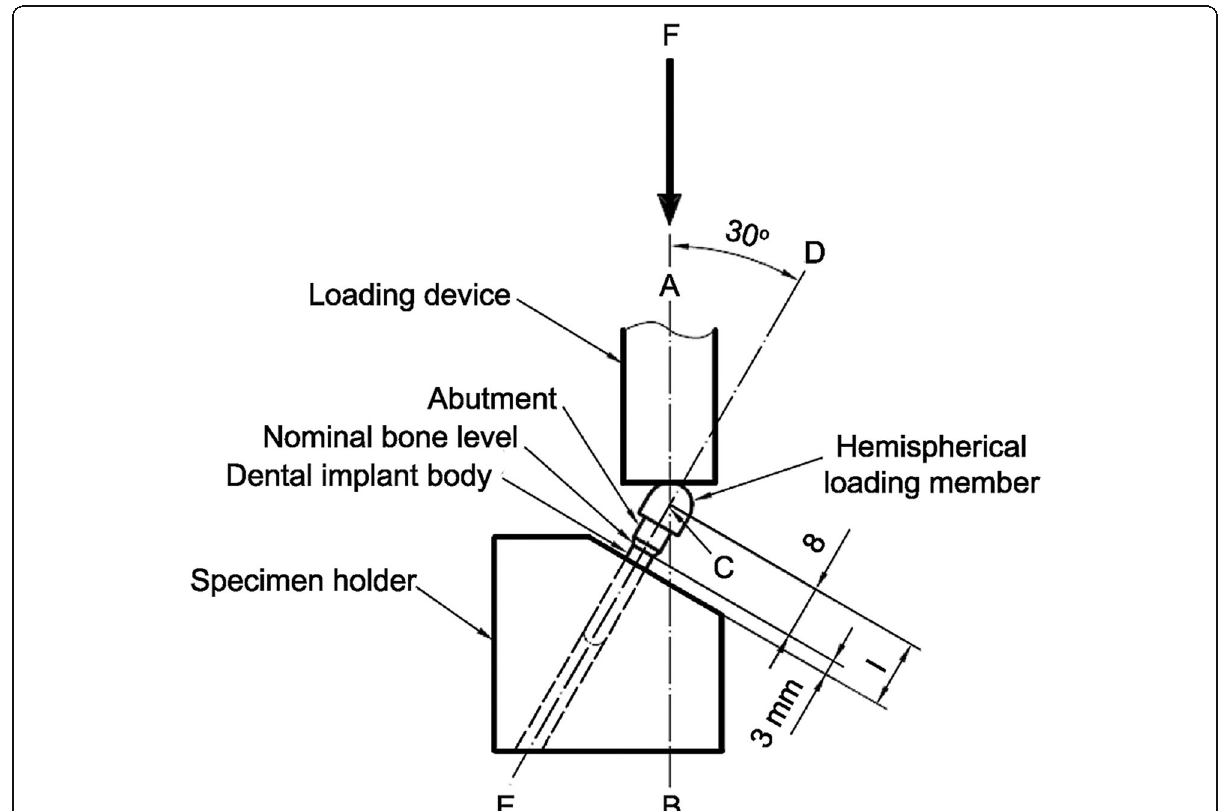
Fig. 2 Schematic of test setup according to The ISO 14801